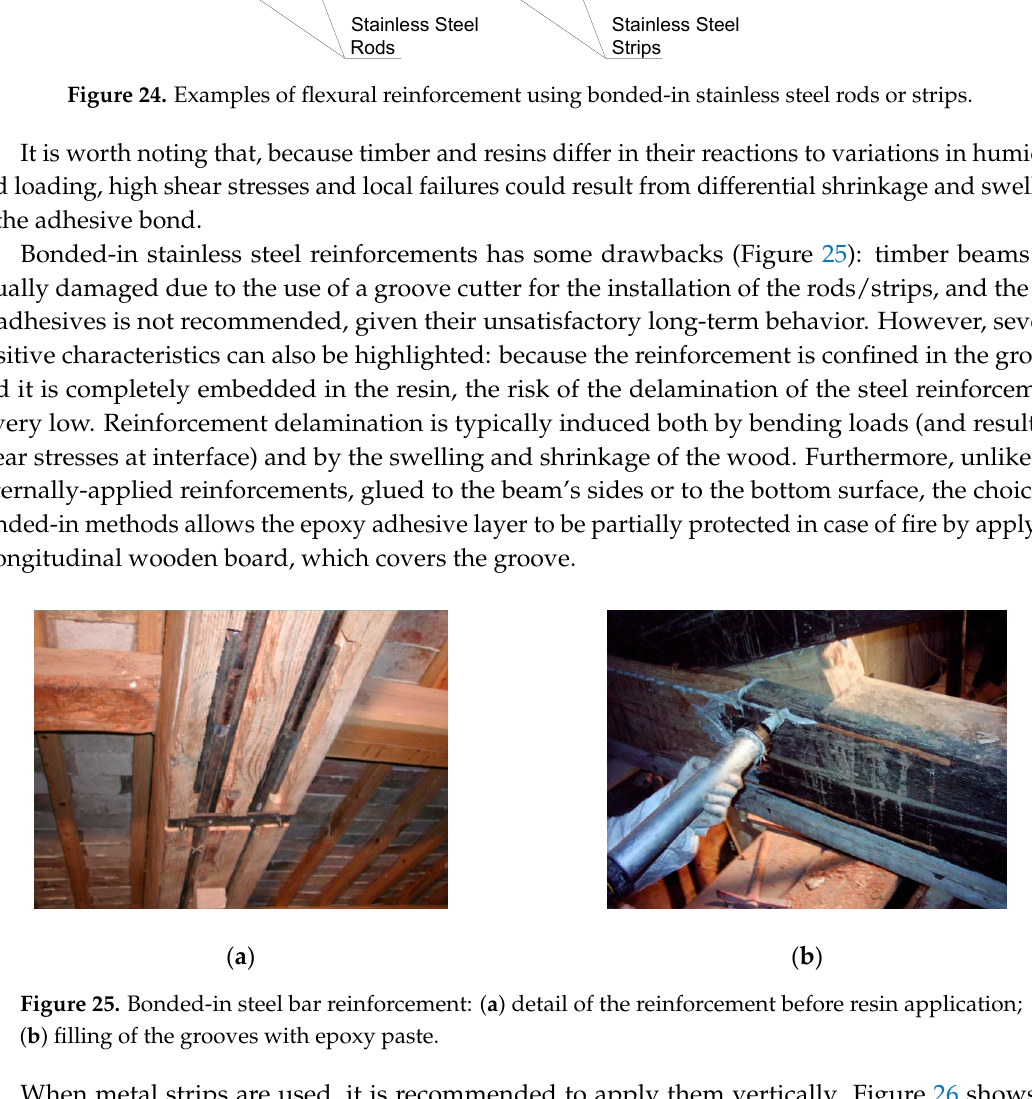
Figure 24. Examples of flexural reinforcement using bonded-in stainless steel rods or strips.